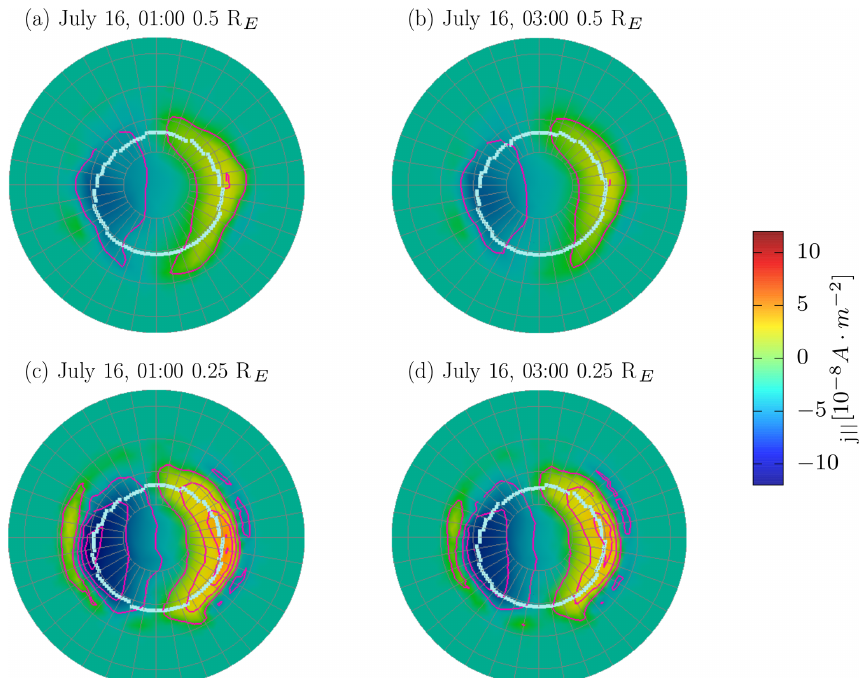
Figure 10. The Northern Hemisphere field-aligned current pattern in GUMICS-4 simulation at 01:00UT (a, c) and at 03:00UT (b, d) on 16 July 2012. Panels (a) and (b) or (c) and (d) , respectively, show the results of the simulation run in which 0.5 or 0.25 R E maximum spatial resolution was